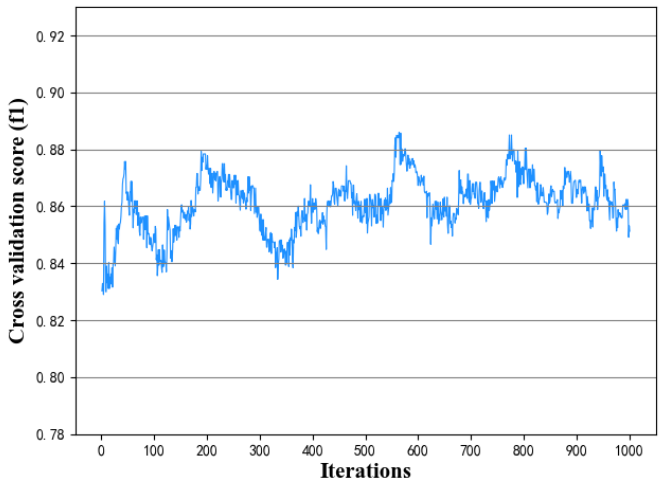
Figure 14. Effect of the iterations on prediction model performance.